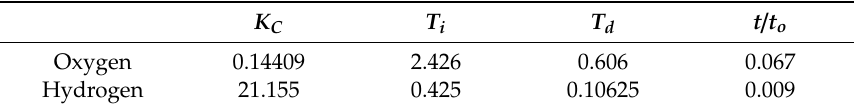
Table 5. Controller tuning